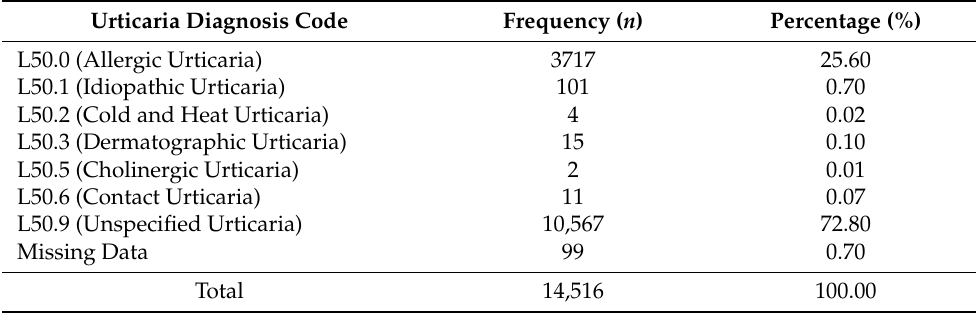
Table 1. Urticaria-related emergency department visits by urticaria diagnosis codes San Joaquin Valley,